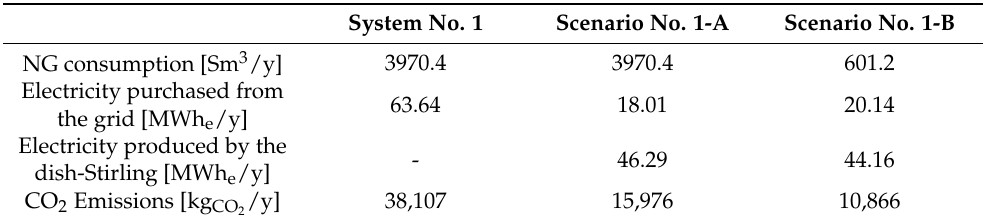
Table 3. Annual results for System no. 1, Scenario no. 1-A, and Scenario no. 1-B.